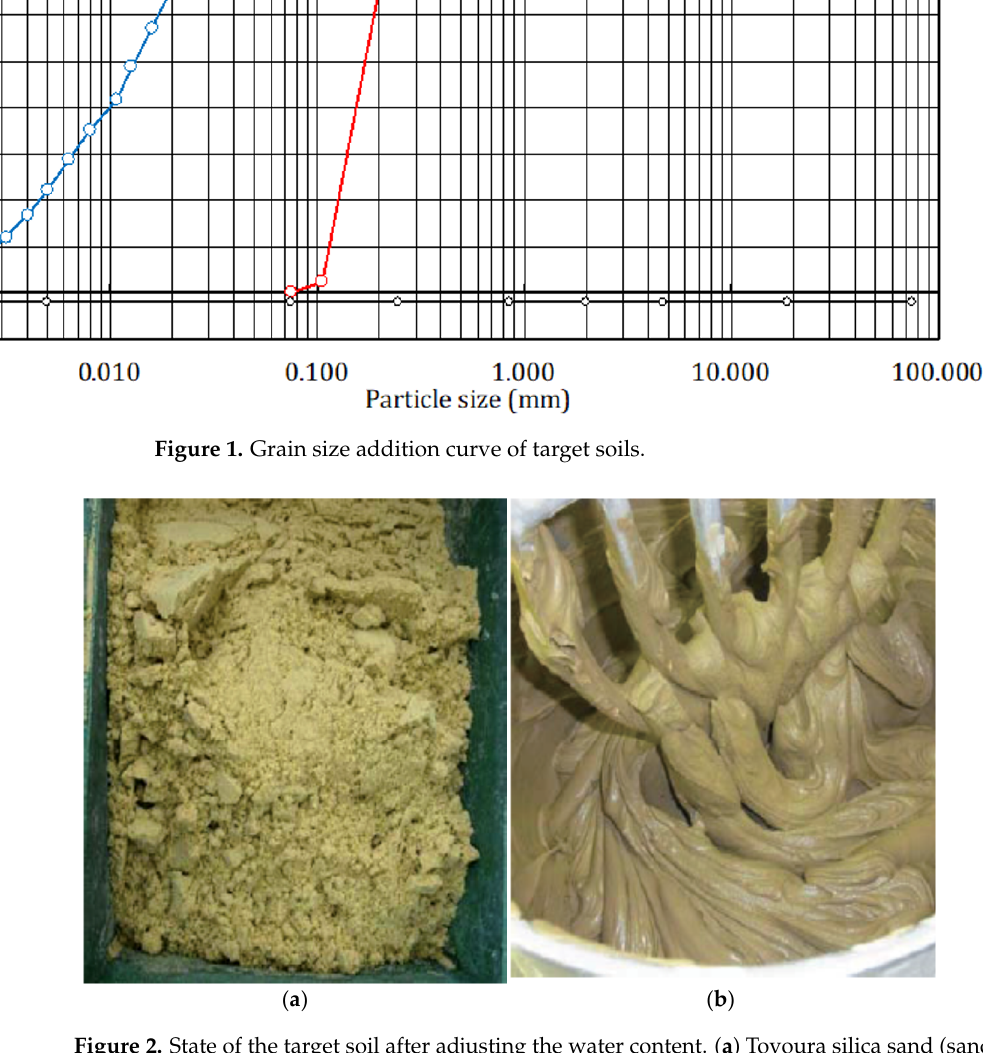
Figure 2. State of the target soil after adjusting the water content. ( a ) Toyoura silica sand (sandy soil). ( b ) Tochi clay (cohesive